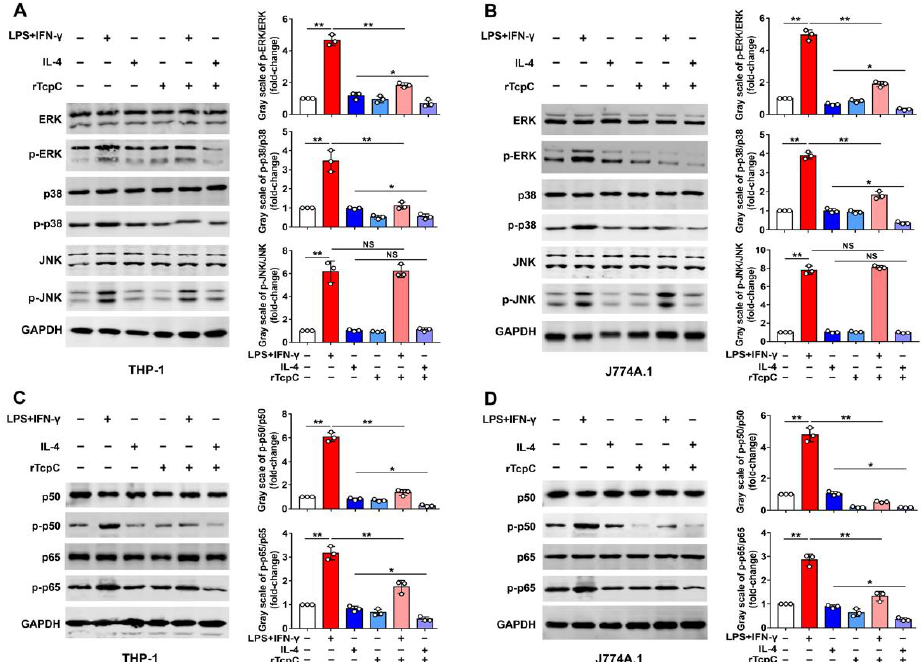
that rTcpC inhibits M1 polarization via blocking the ERK/p38/NF-  B pathway and pro- motes M2 polarization via activating the Akt/STAT6 pathway. motes M2 polarization via activating the Akt/STAT6 pathway.